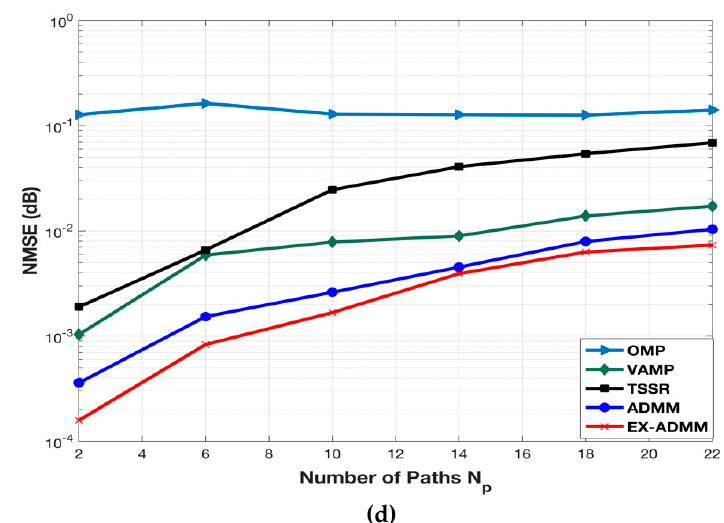
Figure 4. ( a – c ) NMSE at a 30-db transmit SNR for a 64 × 64 mmWave MIMO channel at T = 400, T = 800 and T = 1200, with respect to algorithmic iteration for di ff erent γ values. ( d ) The e ff ect of NMSE for multiple paths N p at T =